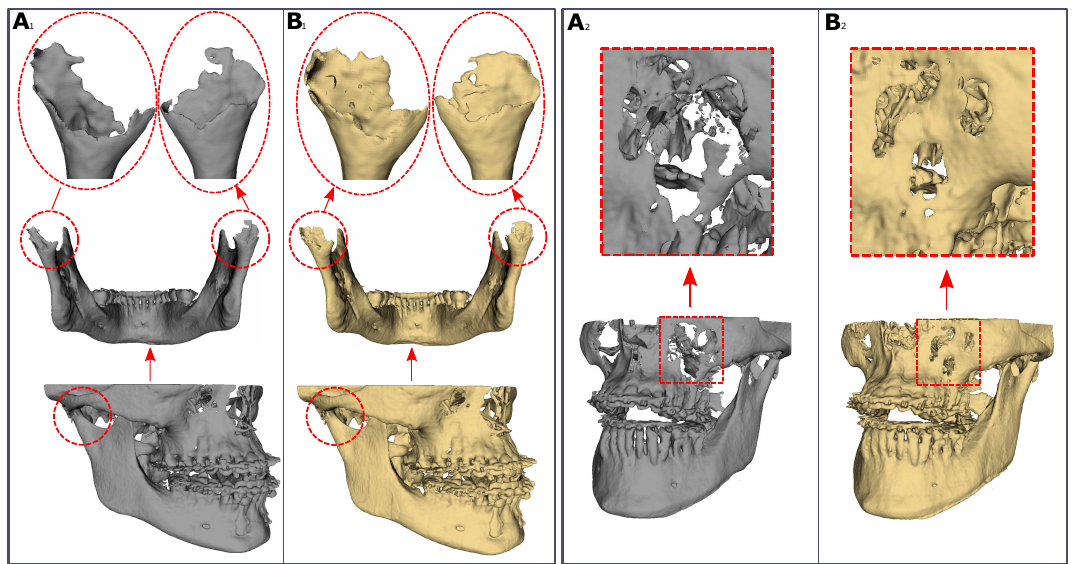
Figure 8. Evaluation of two random selected 3D models using different segmentation methods. ( A ) represents 3D models segmented using a global threshold method by the surgeon, ( B )—segmented with proposed method (region of interest: 1 –condyles, 2